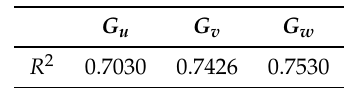
Table 8. Coefficients of determination for G k .